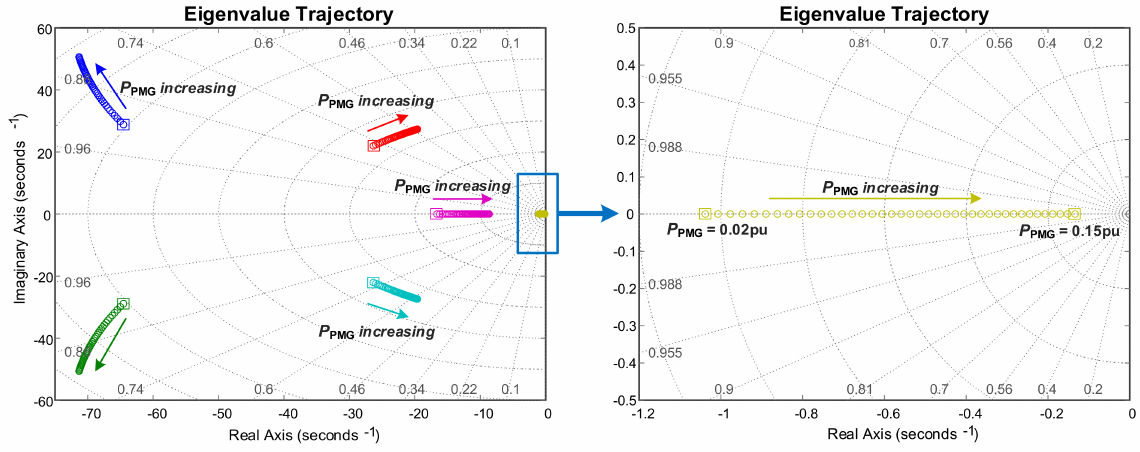
Figure 18. Eigenvalue trajectory for PMG power